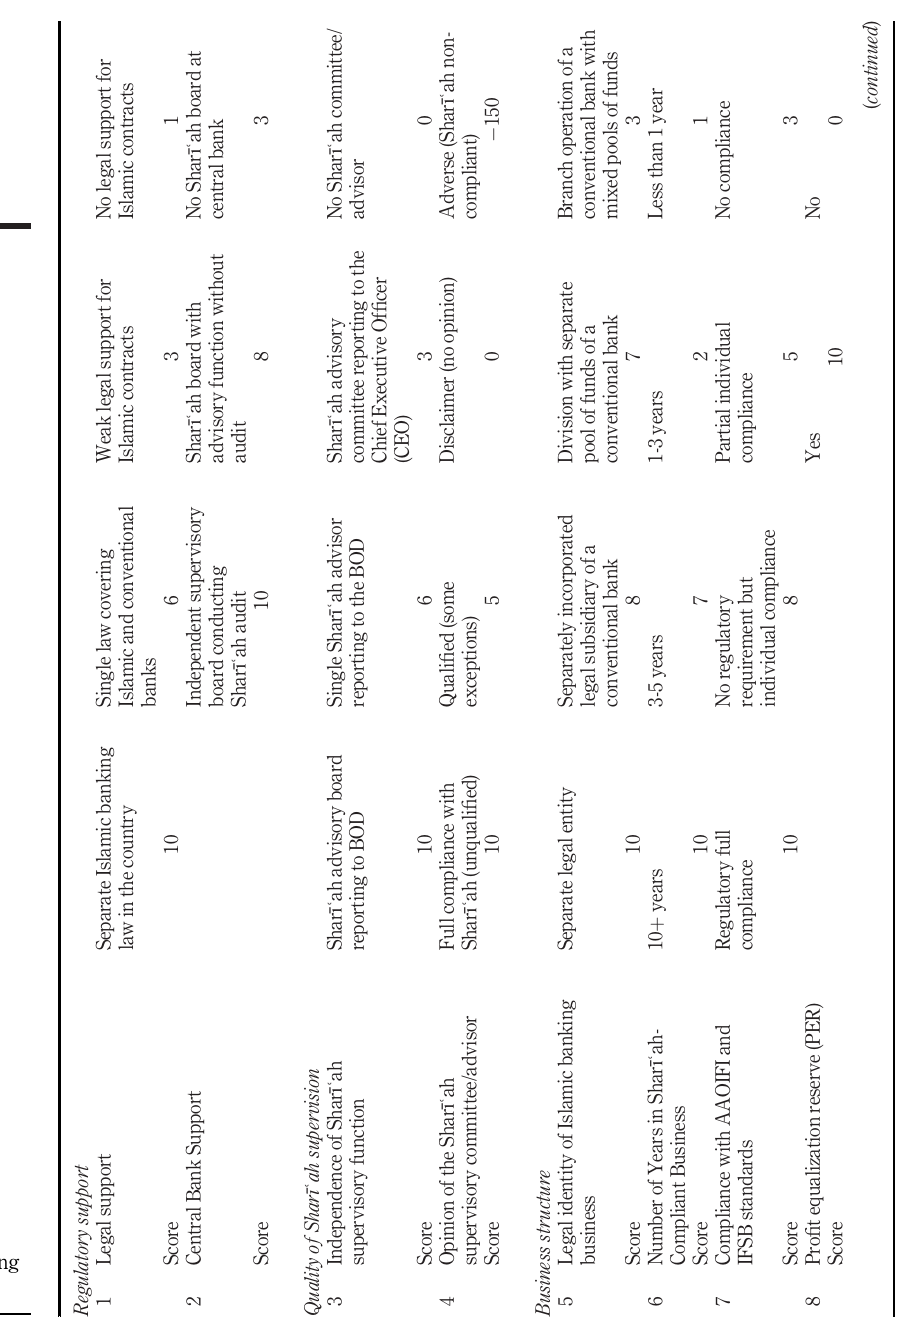
Table I. Shar ī ʿ ah risk rating